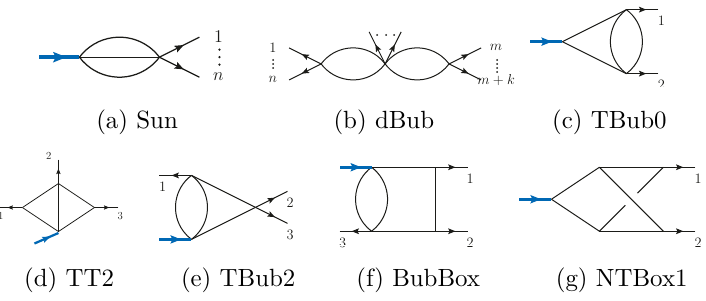
Figure 4. Master integrals for the two-loop minimal form